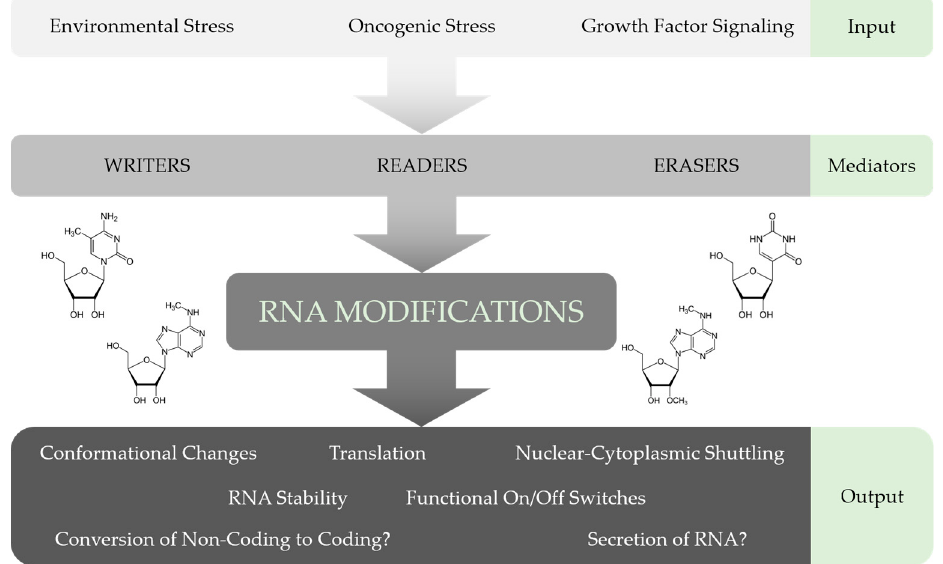
Figure 3. Putative information flow impacting chemical RNA modifications. Internal and external signals lead to epitranscriptomic changes, which are applied by writer and eraser proteins, and subsequently conveyed by reader proteins. Some functions of these epitranscriptomic marks have already been shown while additional mechanisms can be envisioned.